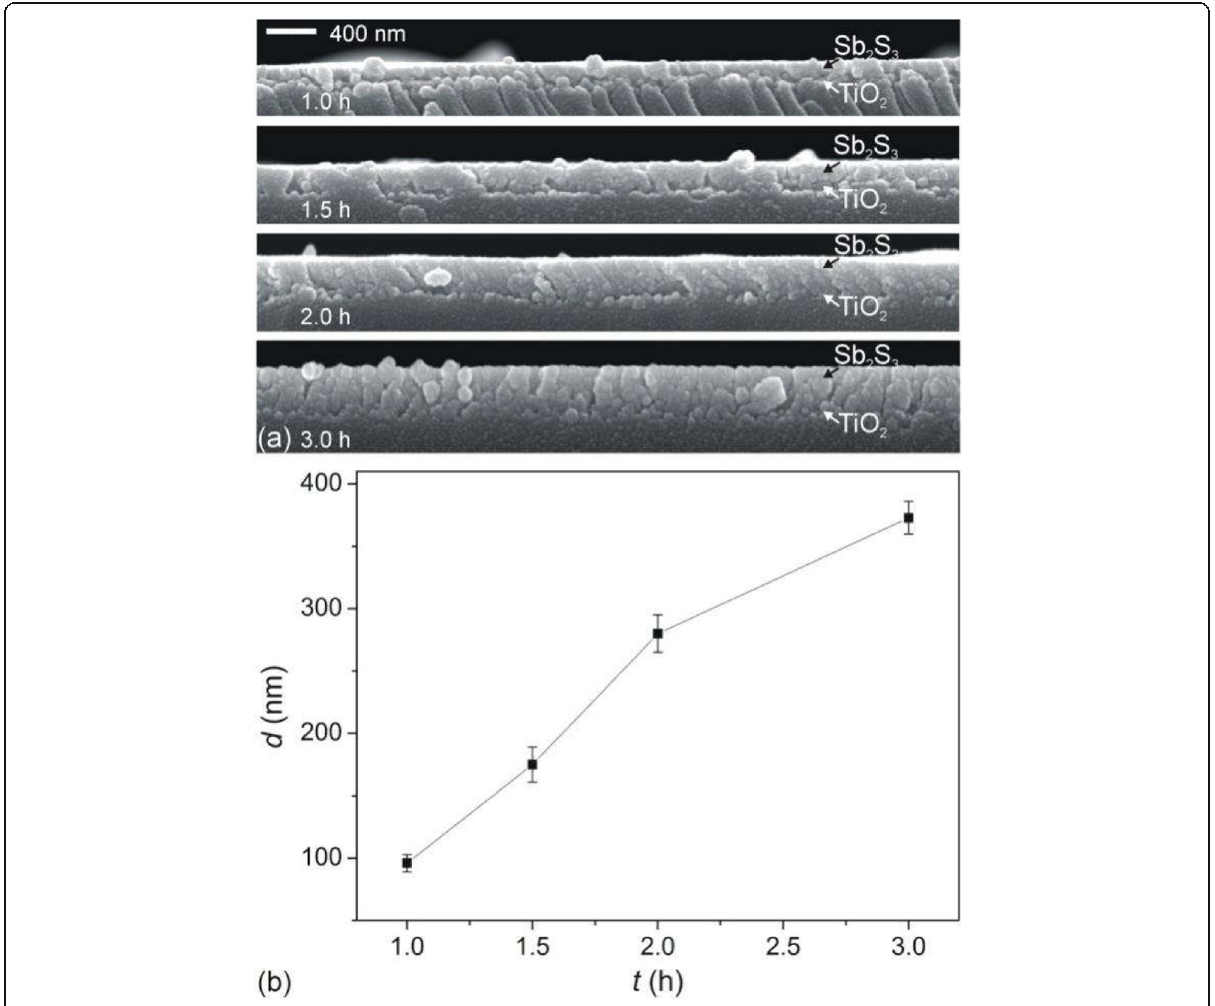
Fig. 2 a Cross-sectional FE-SEM images of Sb 2 S 3 films on TiO 2 dense layer-coated glass substrates. b Average Sb 2 S 3 thickness d plotted as a function of the CBD reaction time t for the Sb 2 S 3 film deposition. The values were estimated by the FE-SEM cross-section